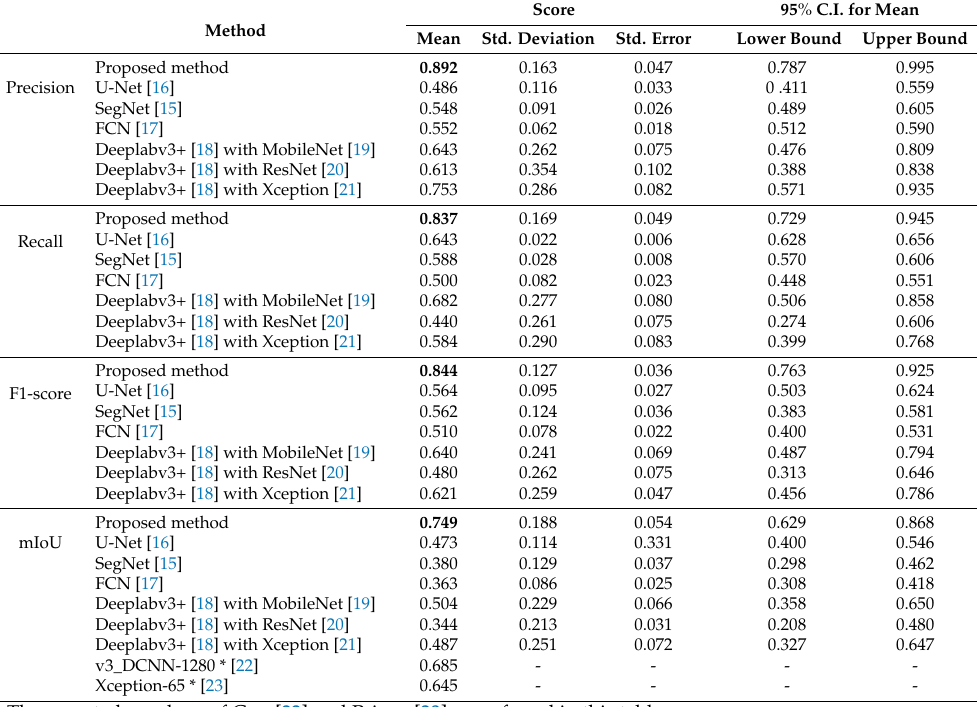
Table 1. The quantitative evaluation of the proposed method and the baseline approaches in the segmentation of metastases on H–E WSIs.